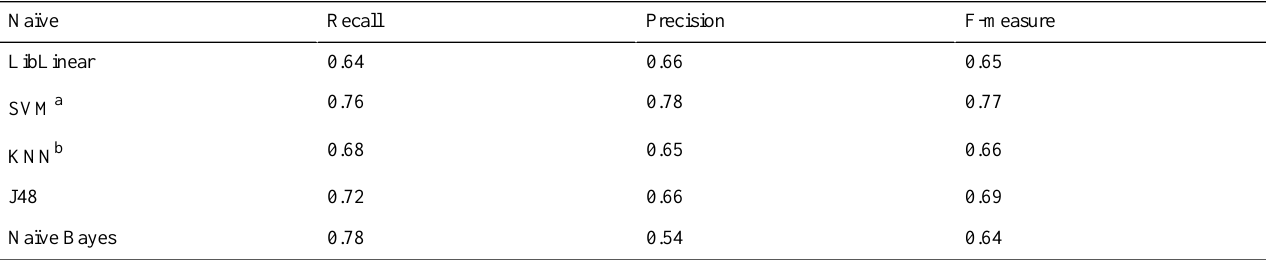
Table 3. Machine learning classifiers applied to peer